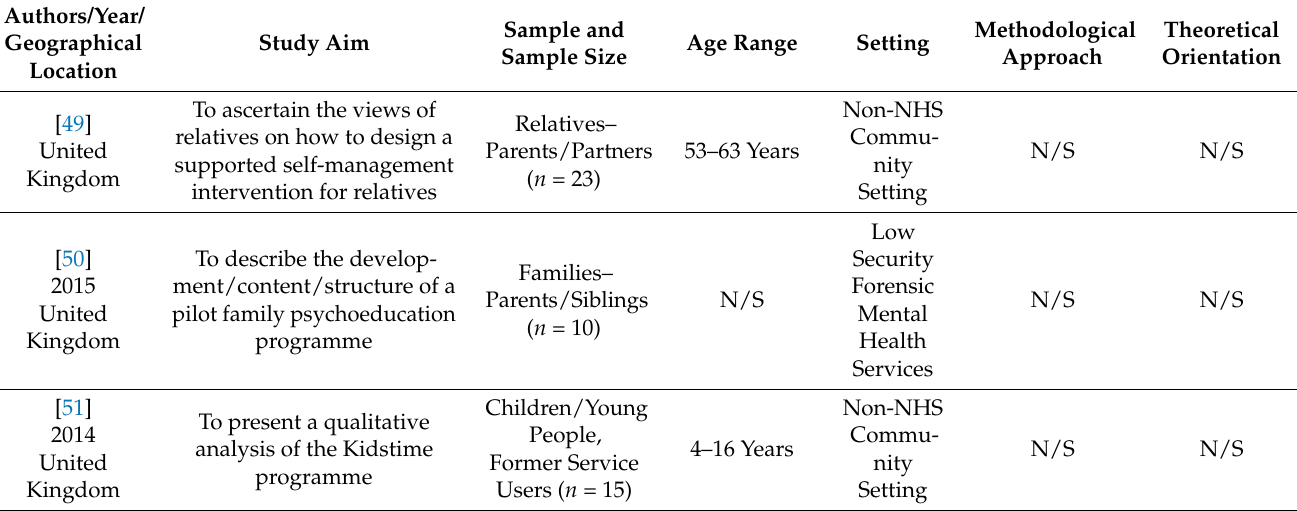
Table 2. Comparative appraisal of included studies.